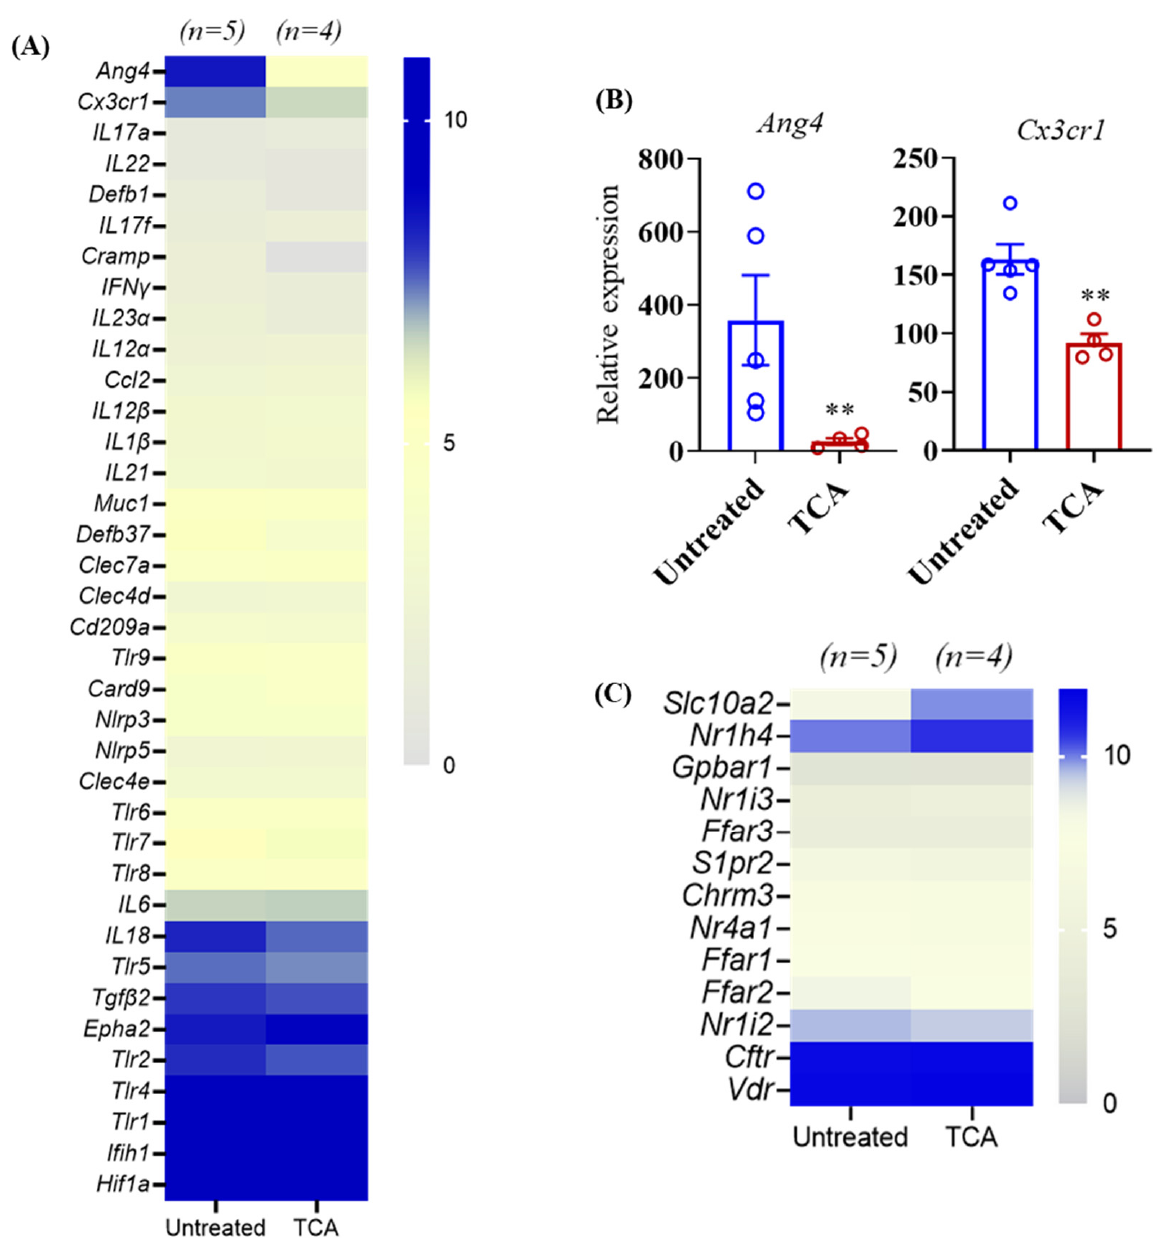
Figure 5. TCA inhibits the expression of ang4 and CX3CR1 in the colon in vivo. Colon tissue from untreated and TCA-treated mice collected after 10 days of CA infection and treatment were RNA-sequenced to examine the expression level of host defense genes. ( A ) Average relative expression of host defense genes in untreated and TCA-treated mice is shown. ( B ) Relative expression of ang4 and Cx3cr1 in untreated and TCA-treated mice is shown. ( C ) Average relative expression of intestinal metabolite receptors in untreated and TCA-treated mice is shown. Four to five mice per group were used. Data represent mean ± SEM. Statistical significance was evaluated using the Student’s t -test. p values ≤ 0.01 (**) was considered statistically significant.